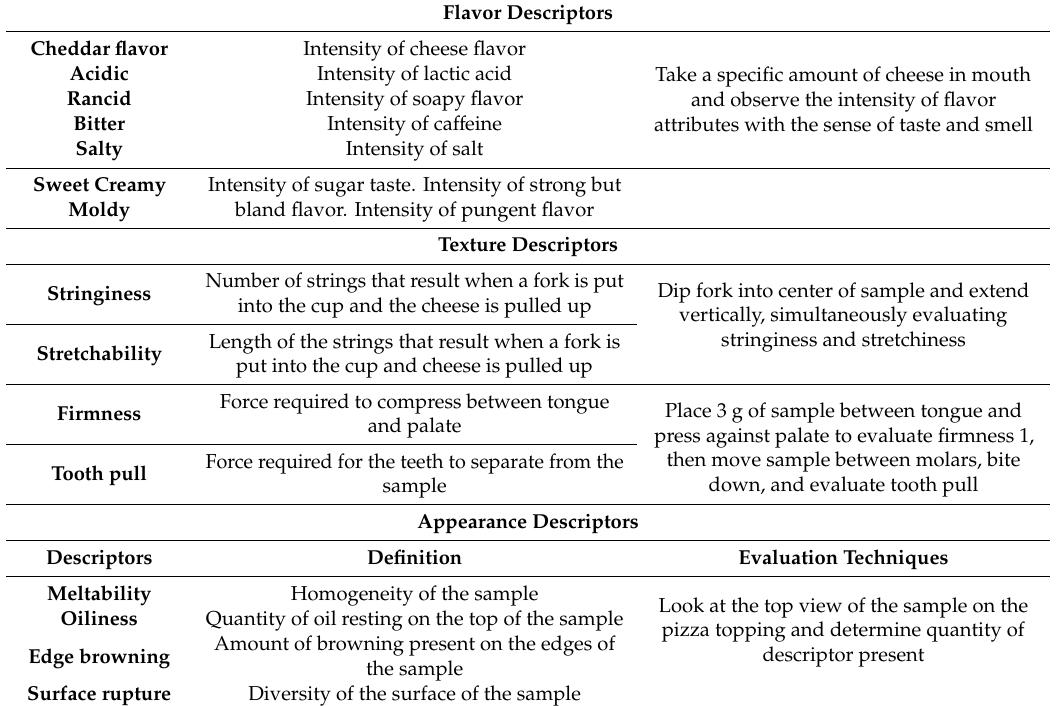
Table 1. Sensory descriptors and definitions along with their evaluation technique. Flavor